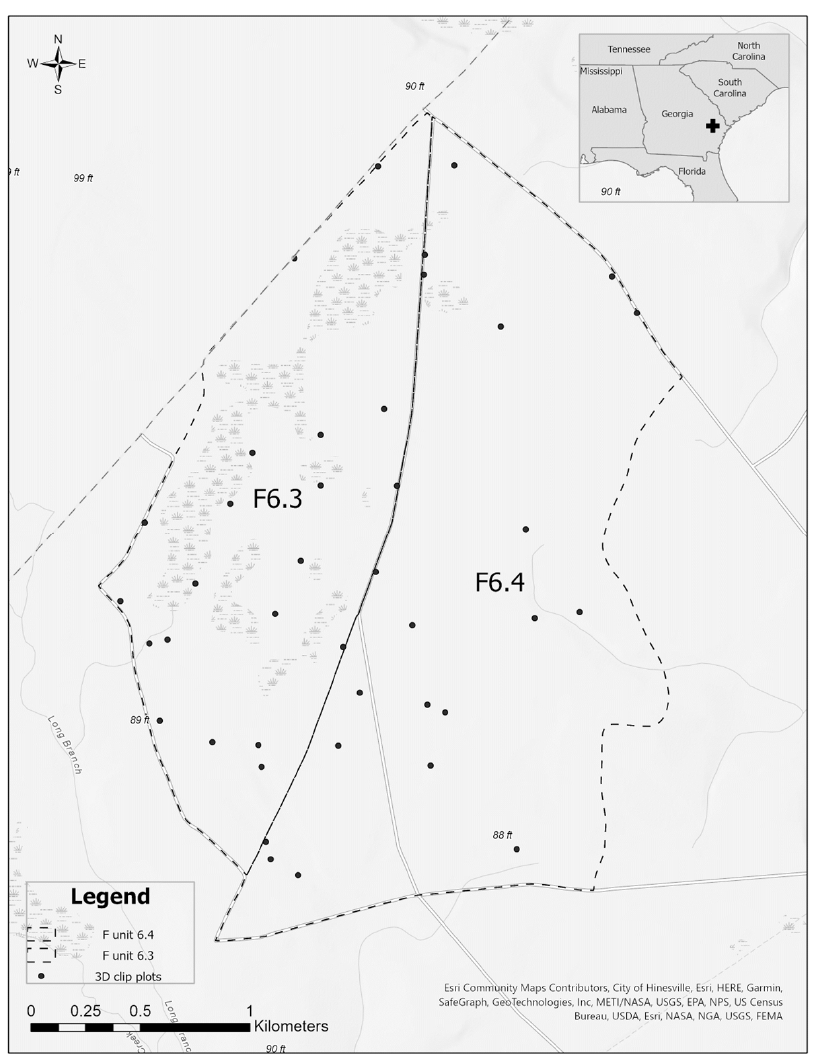
Figure 1. Study area and sampling distribution of co-located TLS scans and vegetation and fuel biomass samples ( n = 41). They were sampled before and after two prescribed burns.